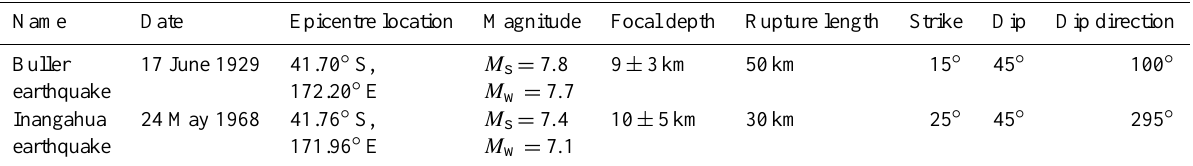
Table 1. Summary of 1929 and 1968 earthquakes.